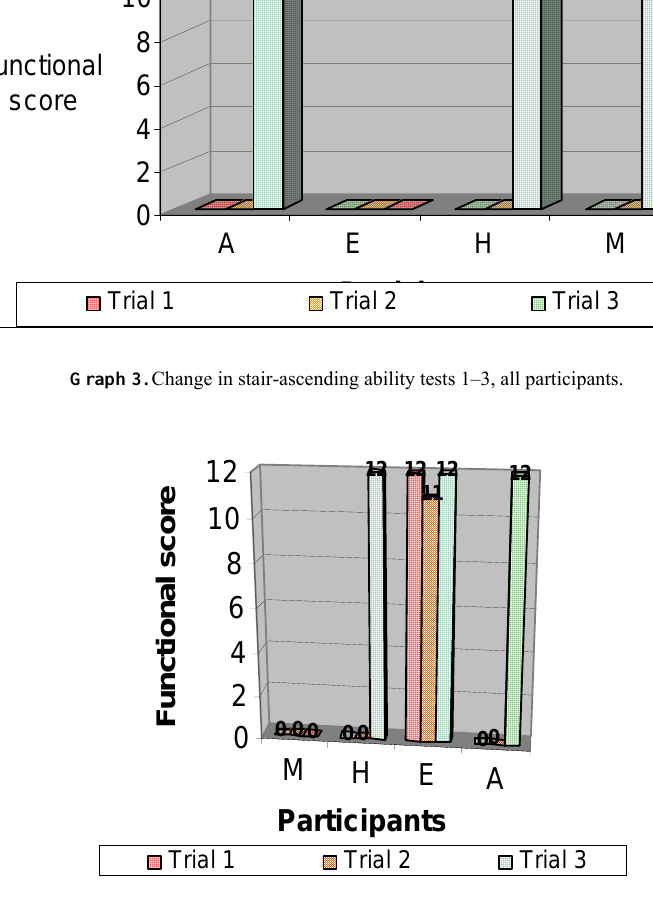
Graph 4. Change in knee-walking ability tests 1–3, all